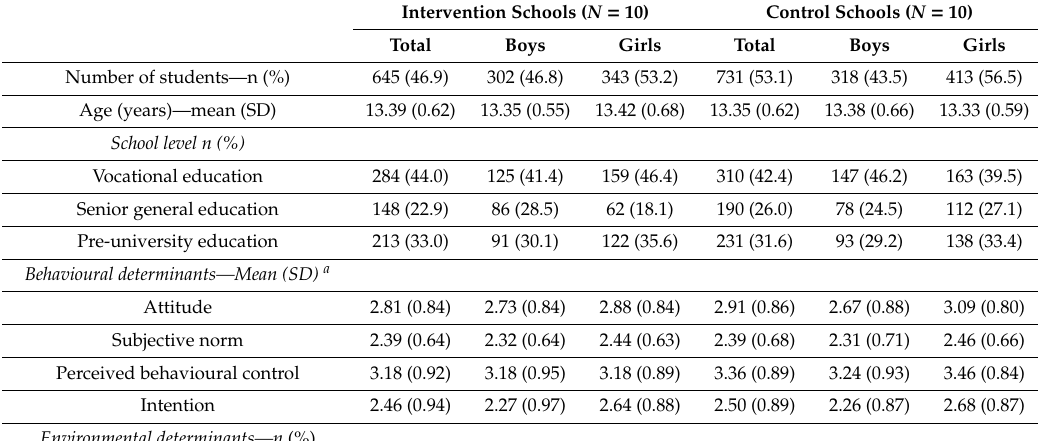
Table 1. Baseline characteristics of students divided by intervention or control school and